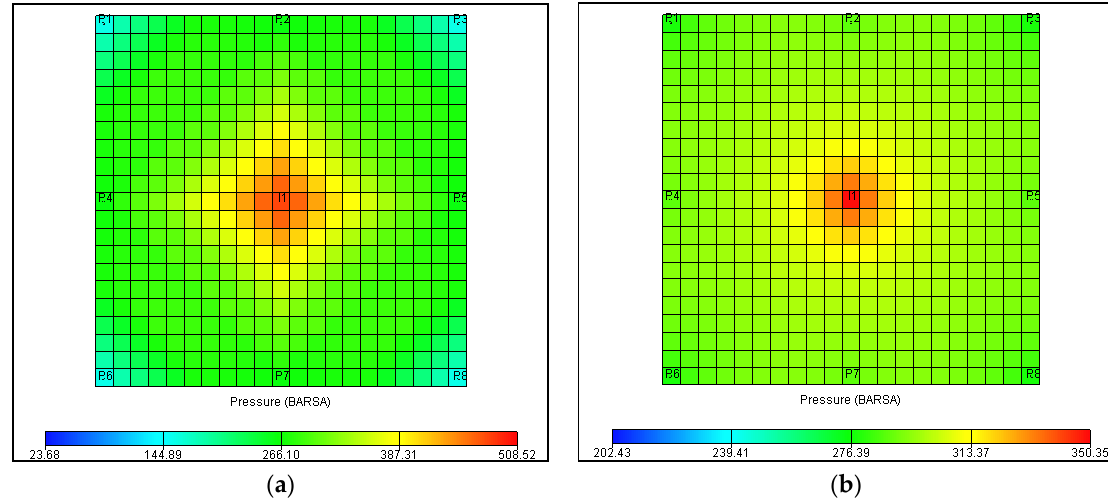
Figure 9. Pressure distribution map on January: ( a ) Darcy seepage; ( b ) non-Darcy seepage.